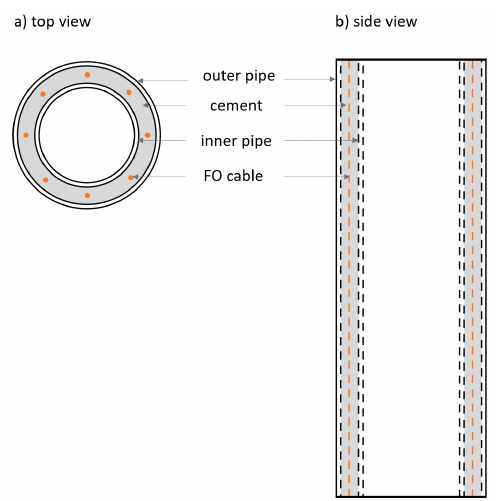
Figure 5. Schematic diagram of an axially-distributed fibre-optic sensor described in